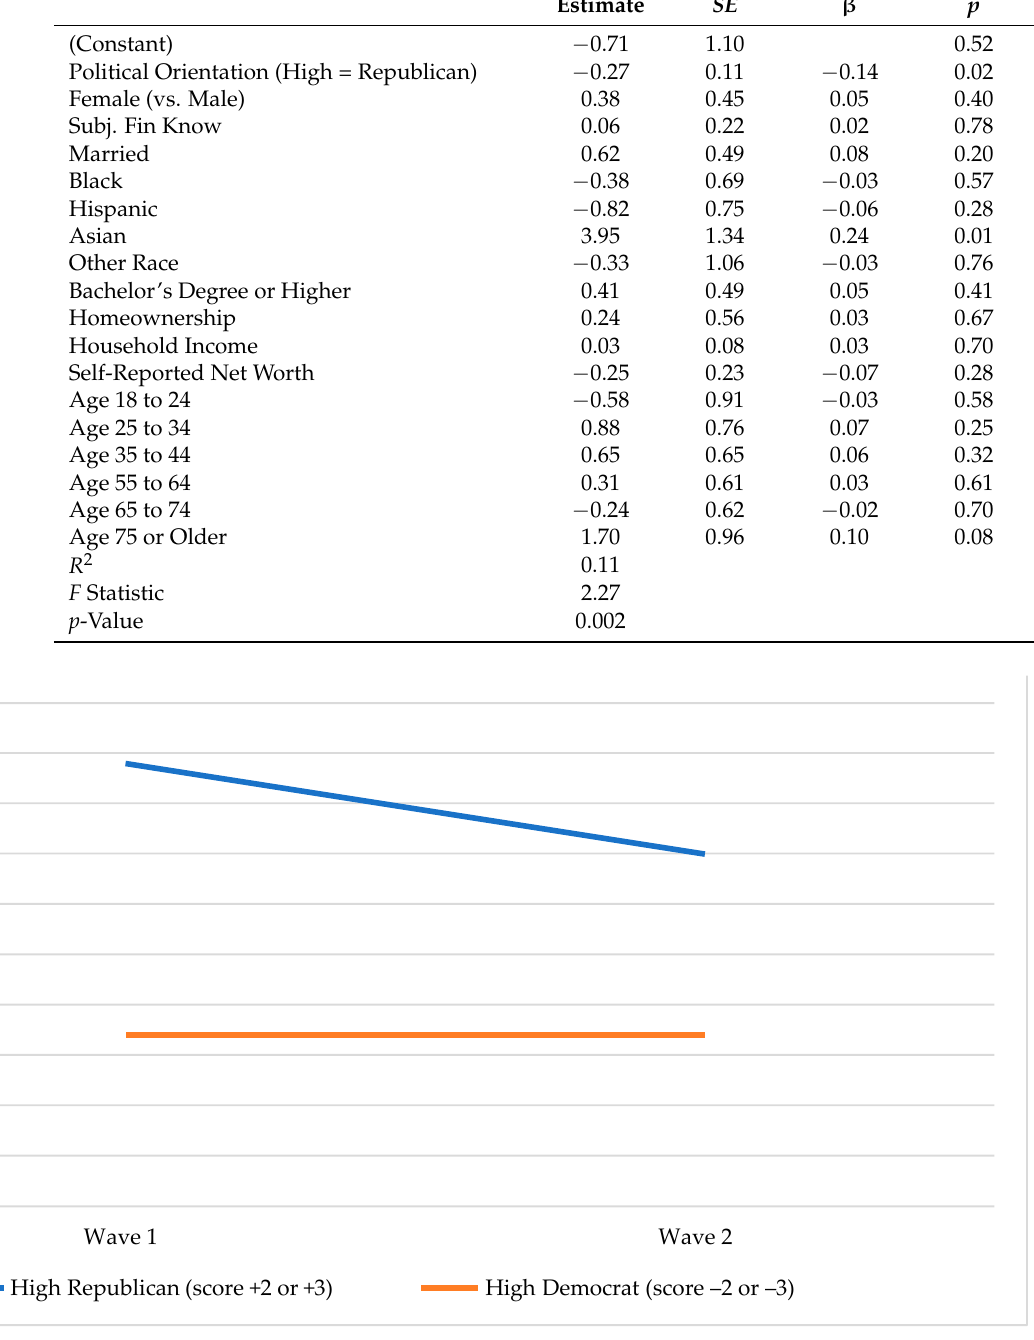
Figure 1. Change in FRT from Wave 1 to Wave 2 for those with high Republican and high Democratic affiliation. Table 7. Regression showing change in financial risk tolerance (FRT) from the Wave 1 to Wave 2 survey based on Republican Party affiliation.